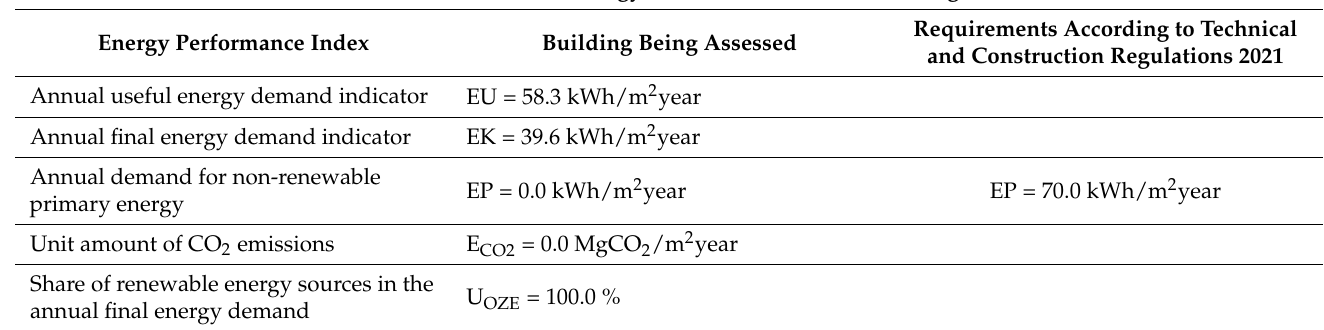
Table 4. A collective summary of the results of the demand for individual energies for variant VIII (own